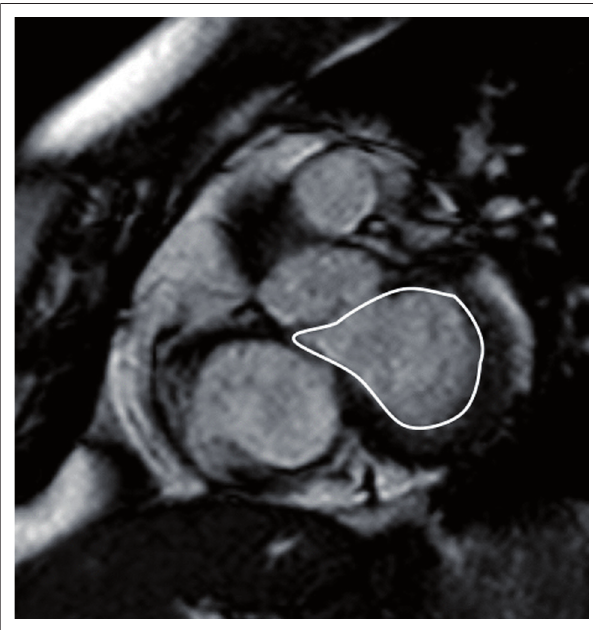
FIGURE 5: Single short-axis cine SSFP image of the basal LV myocardium. The left ventricular outflow tract should be included in the blood pool when contouring the LV endocardium contour up to the level of the aortic valve leaflets.